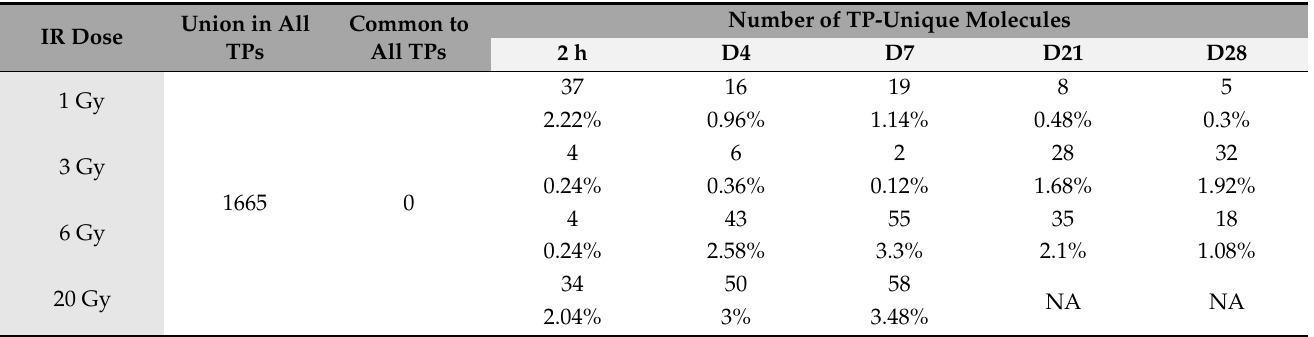
Table 1. Distribution of total SDTGs from global analysis of data in the study (all TPs and IR doses). Number of TP-Unique Molecules IR Dose